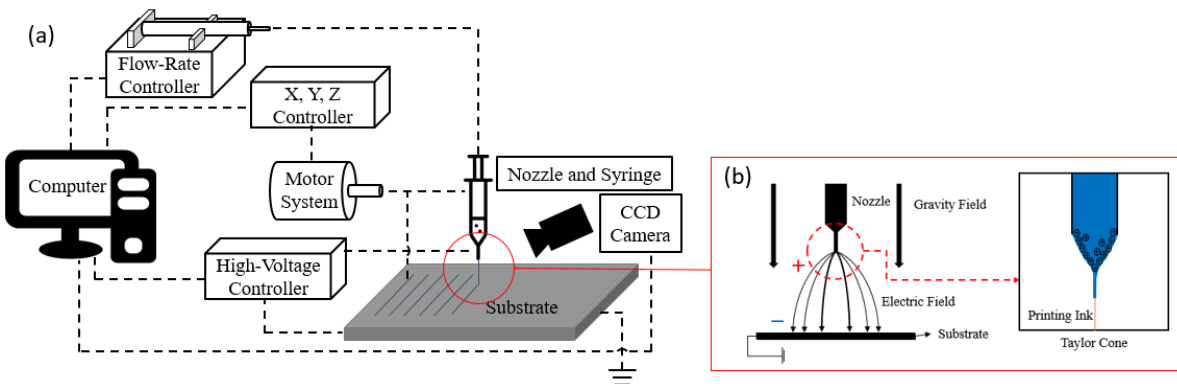
Figure 5. Schematic of the EHD inkjet printing system: ( a ) EHD Inkjet printing equipment, ( b ) Meniscus formation.